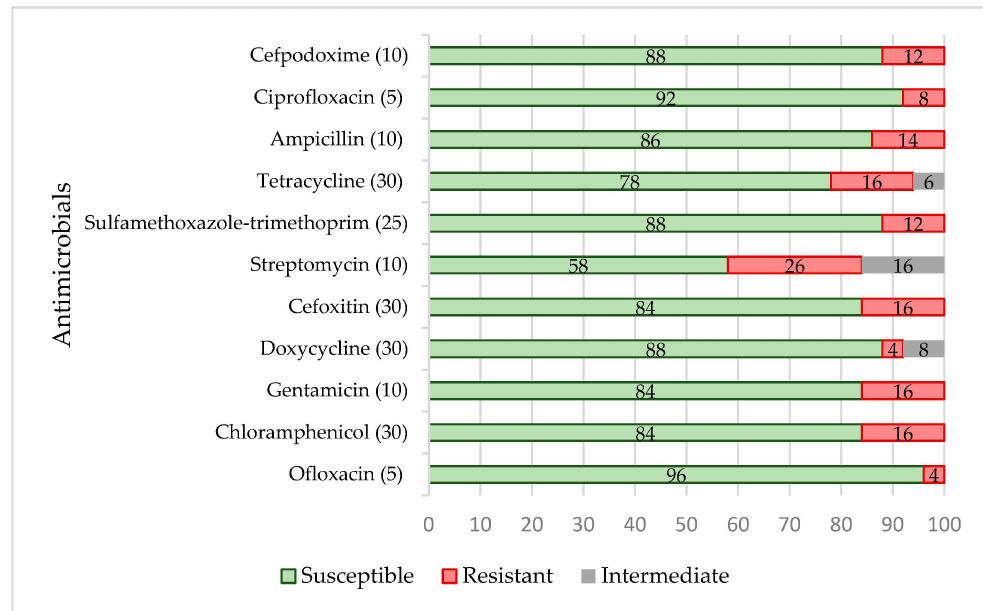
Figure 1. Phenotypical antimicrobial resistance (%) patterns of the Salmonella isolates from reptiles (n = 50). Intermediate describes the zone of inhibition in between “susceptible” and “resistant”. The numbers in brackets near the antimicrobial agent represent the antimicrobial concentrations ( µ g) of the